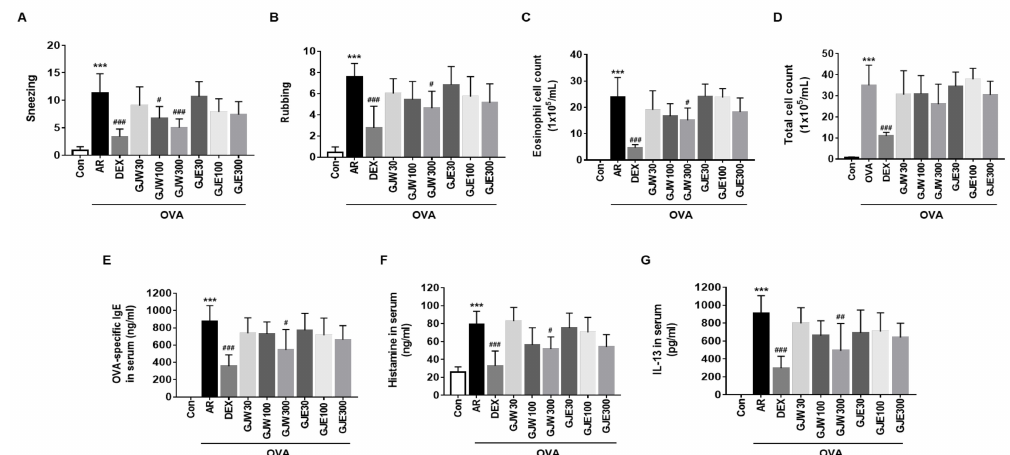
Figure 2. Effects of Gardenia jasminoides water (GJW) and 70% ethanol (GJE) extracts on allergy symptoms, nasal lavage fluid cells, and serum parameters. The AR mice were orally administered with GJW, GJE or DEX once daily, and anesthetized and euthanized 24 h after the last treatment. Allergy symptoms such as sneezing ( A ) and rubbing ( B ) scores were recorded at the time of the final intranasal treatment. Eosinophil ( C ) and total cell counts ( D ) were measured in the nasal lavage fluid. Serum levels of ovalbumin-specific immunoglobulin E (IgE) ( E ), histamine ( F ), and interleukin 13 (IL-13) ( G ) were evaluated using enzyme-linked immunosorbent assays. Data are presented as the means ± standard deviations ( n = 6–8, each group). *** p < 0.001 vs. the non-sensitized (Con) group; # p < 0.05, ## p < 0.01, and ### p < 0.001 vs. the allergic rhinitis (AR) group. DEX, ovalbumin-sensitized with 1 mg/kg dexamethasone; OVA,